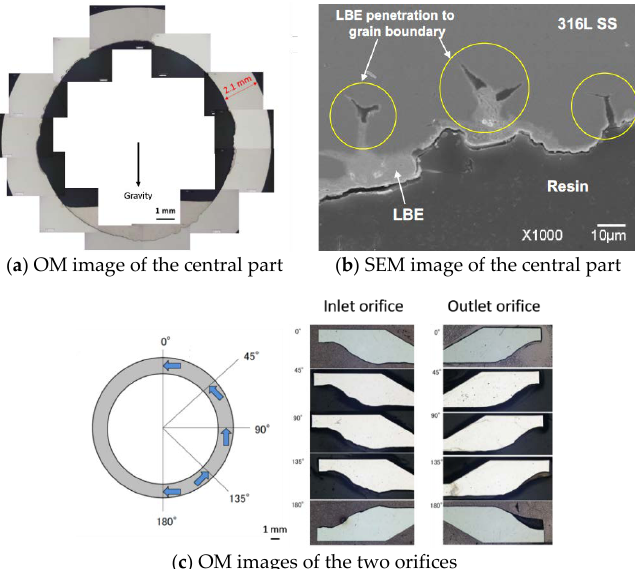
Figure 7. OM and SEM images. ( a ) OM image of cross-sections of the specimen of the central straight pipe; ( b ) SEM image of cross-section of the specimen of the central straight pipe; ( c ) OM images of the two orifices at various circumferential angles.